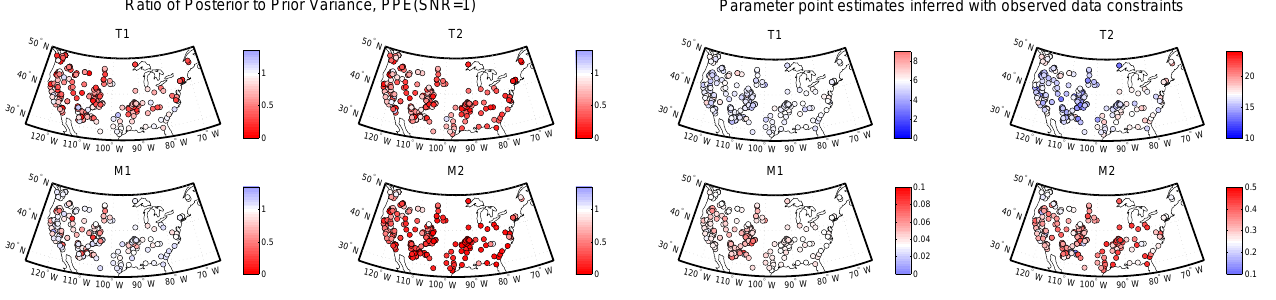
Fig. 4. Posterior medians of VS-Lite growth parameters. Note that the color scale for each parameter ranges over the interval on which the prior is supported, and is calibrated so that white indicates the prior median.